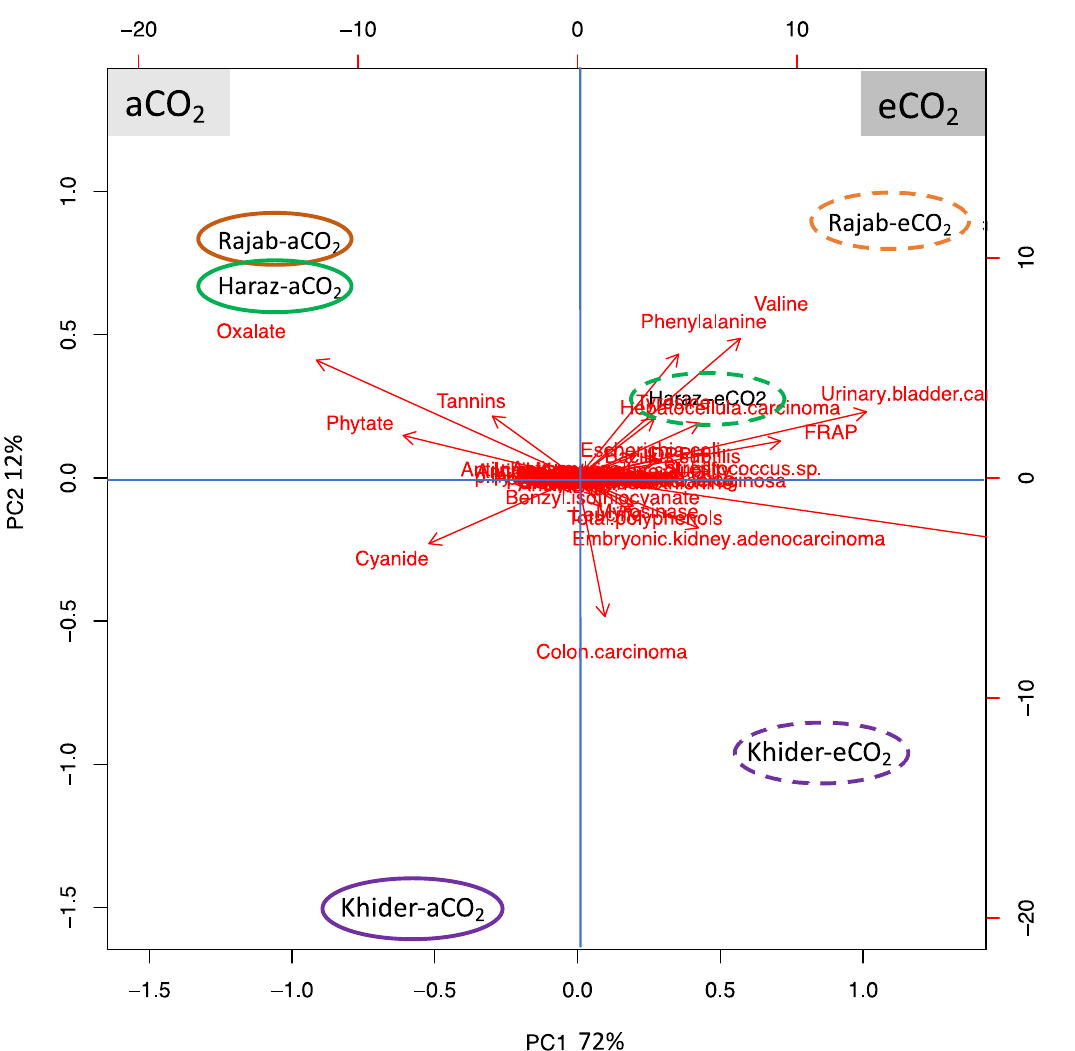
Figure 4. Principal component analysis of the average levels of assayed metabolite and biological activities in sprouts of three Lepidium sativum cultivars grown under either aCO 2 (410 µmol CO 2 mol − 1 air; control) or eCO 2 (620 µmol CO 2 mol − 1 air). Variances explained by the first two components (PC1 and PC2) appear in parentheses. The PCA is based on Z-score normalized data. Green, purple and orange circles represent Rajab, Haraz and Khider samples, respectively. Clusters with a dashed or solid outline represent samples grown under eCO 2 or aCO 2 , respectively. The circles were arbitrary.